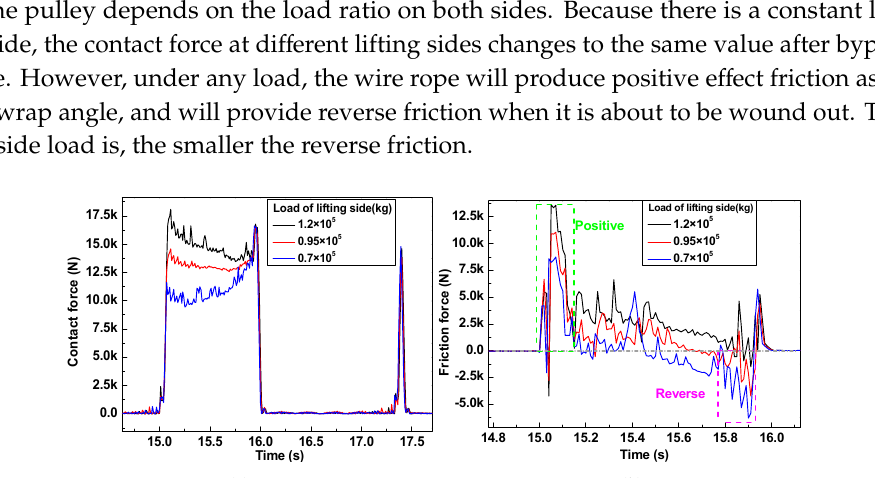
Figure 19. Contact and friction force between the 369th rope element (400 m) and the friction pulley. ( a ) Contact; ( b ) friction.